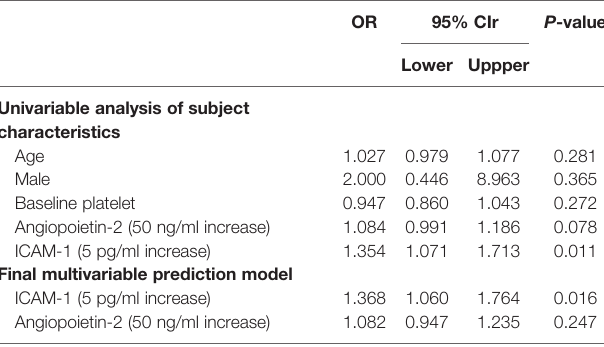
TABLE 4 | Logistic regression analysis evaluating predictors of no response to consecutive low-dose decitabine therapy for corticosteroid resistant ITP patients. OR 95%